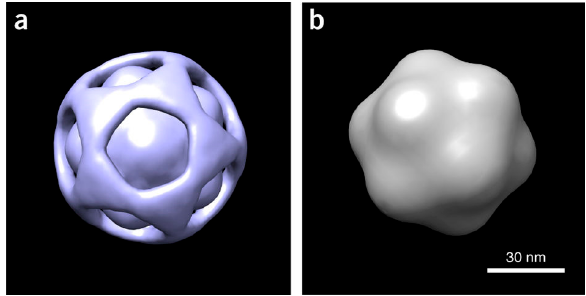
Figure 10. Three-dimensional diffraction pattern and reconstructed structure obtained without conformational analysis. ( a ) Diffraction pattern extracted from 37,550 2D single-particle diffraction snapshots of the PR772 virus, obtained at LCLS; ( b ) Corresponding 3D reconstructed image with a resolution of 9 nm, corresponding to scattering to the edge of the detector. (reproduced with permission from [206]. Copyright Springer Nature, 2017).